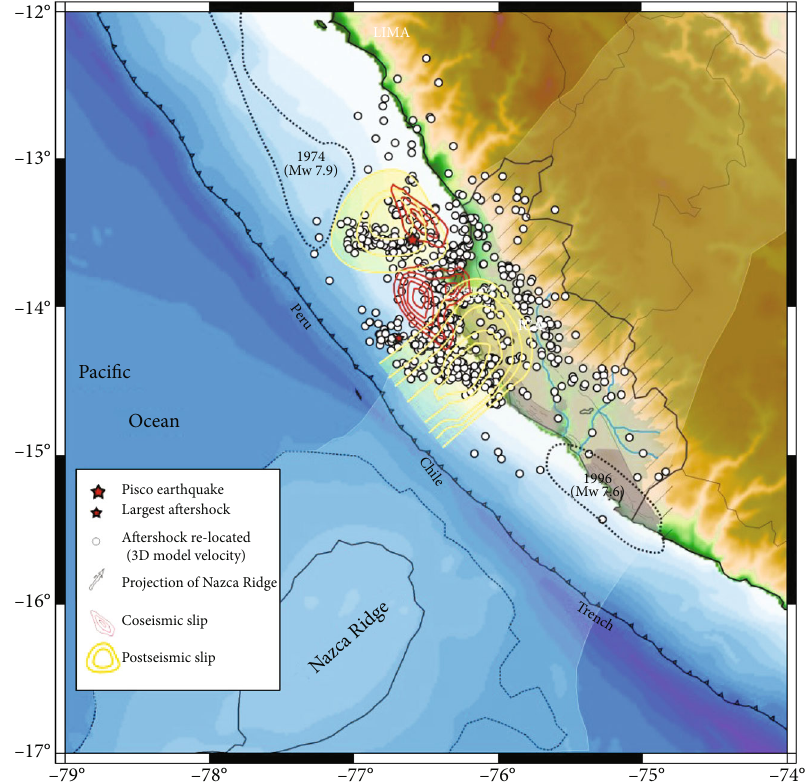
Figure 5: Comparison of the aftershock distribution with coseismic (red contour) and postseismic (yellow contour) slip distribution. The distribution of aftershocks is shown for